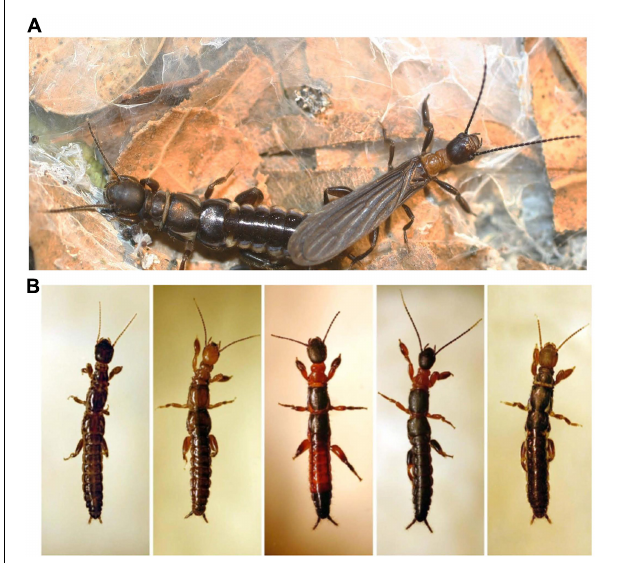
FIGURE 1 | Portraits of Antipaluria urichi. (A) Adult male (winged individual, 1.2 cm long) and female (1.5 cm long) in a lab culture container of dried Live Oak leaves and silk; (B) adult females from five taxonomic families, displaying typical uniform shape and a range of colors (body length not to scale). Families from left to right: Australembiidae, Archembiidae, Embiidae, Oligotomidae, Clothodidae.